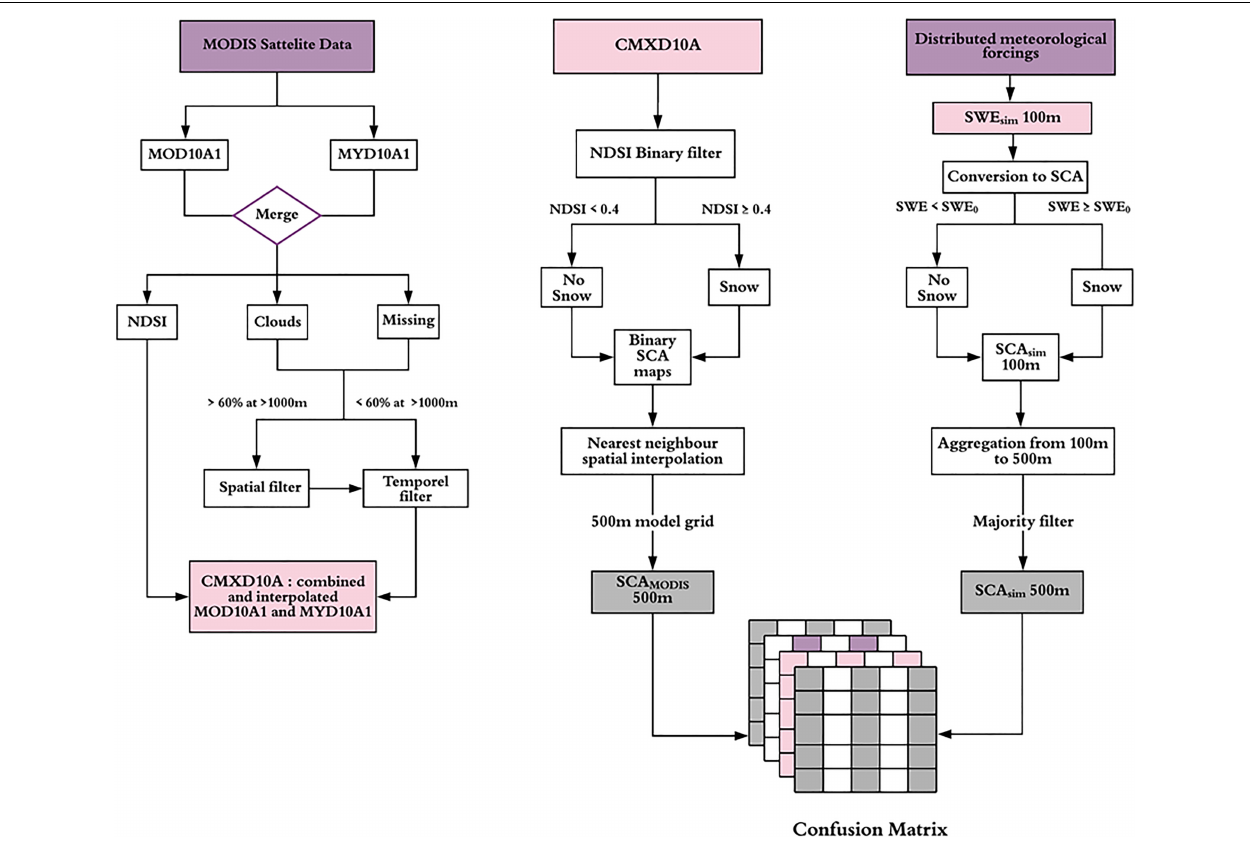
FIGURE 2 | Flowchart describing the steps for processing MODIS data and comparing MODIS and simulated snow cover area (SCA). Purple color, data source; pink, intermediate output; gray, main